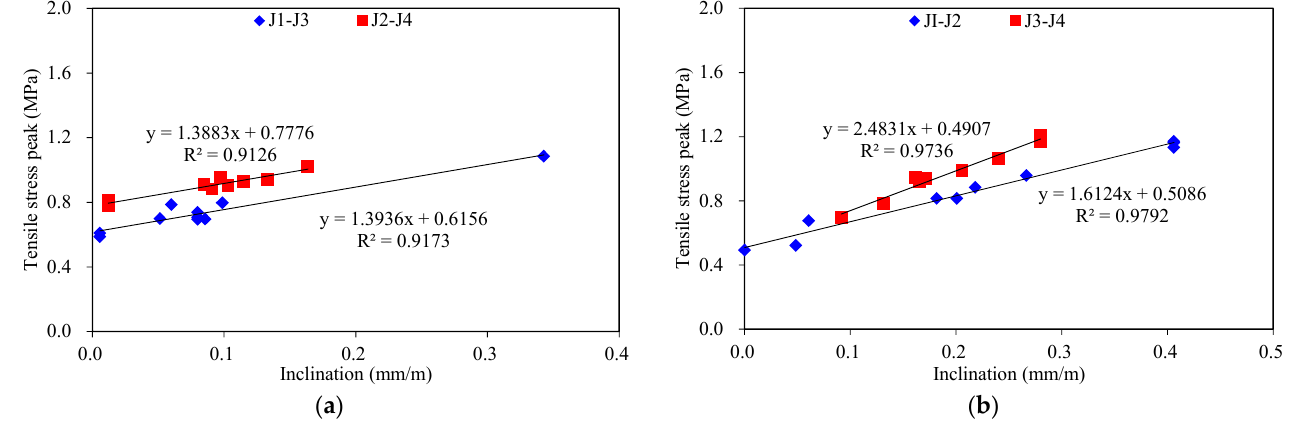
Figure 9. Relationship between the peak tensile stress on the upper surface of the main beams and the inclination of the tower foundation. ( a ) North–south direction; ( b ) east–west direction. Table 4. Fitting equation and correlation coefficient between the peak tensile stress on the upper surface of the main beams and the inclination of the shaft tower foundation.